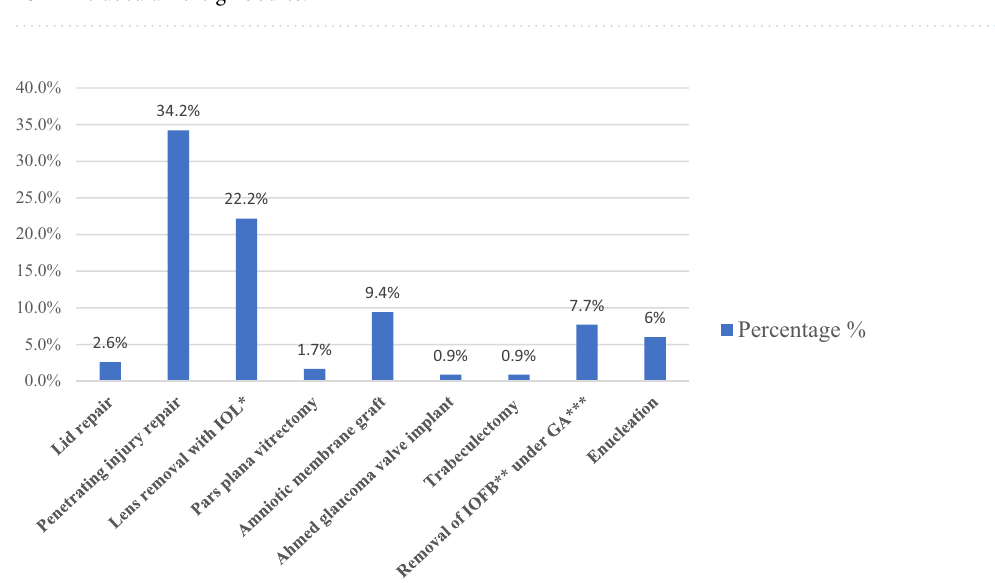
Table 3. Ocular profile of Saudi children with fireworks-related injuries. BCVA best corrected visual acuity, IOFB intraocular foreign bodies.